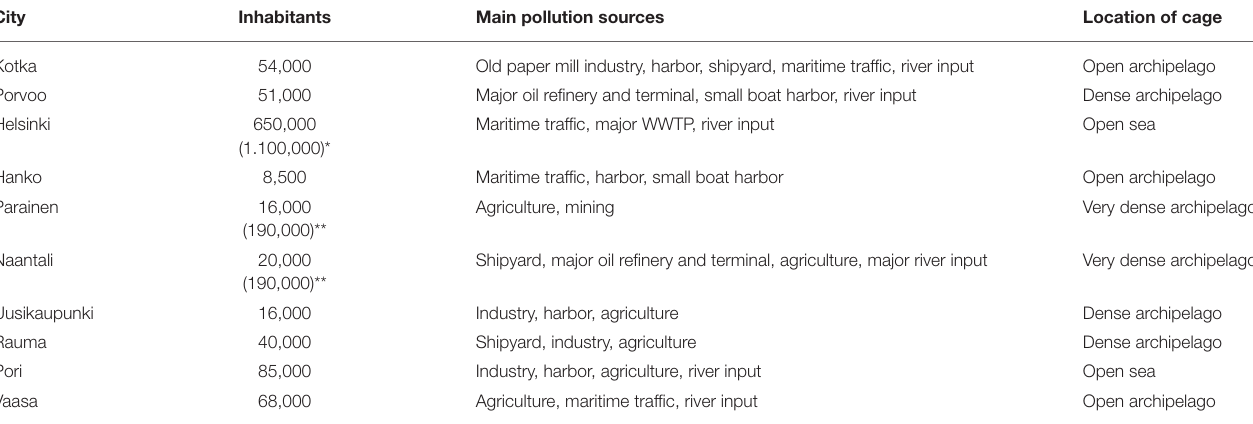
TABLE 1 | Some key characteristics of the study